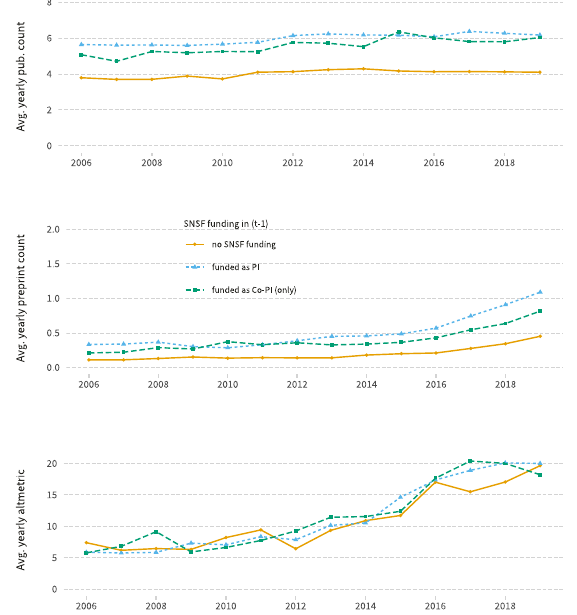
Fig. 1 Time trends of the publication and preprint counts as well as the altmetric score by SNSF funding status in the year before. Shown are the averages of the publication an preprint counts and the altmetrics for each year of observation. PI stands for principal Table 2 Incidence rate ratios (IRR) of the multivariate Negative Binomial models for the article and preprint counts. 1. Articles